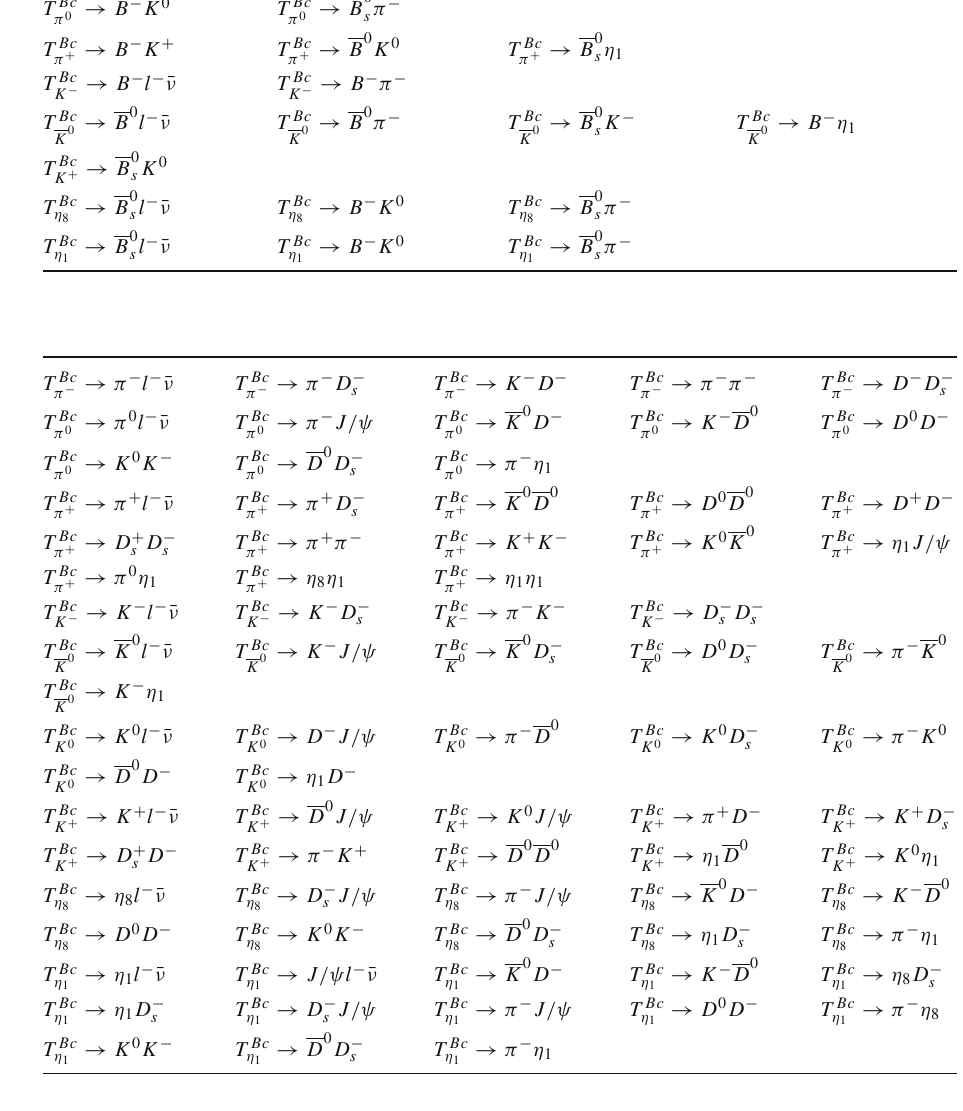
Table 9 Cabibbo allowed T b ¯ c 8 / T b ¯ c 1 ¯ c -quark decays